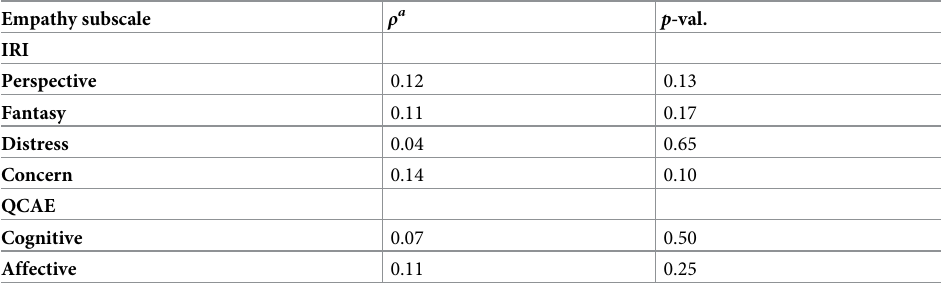
Table 4. Spearman correlation coefficients between allocation decision and empathy